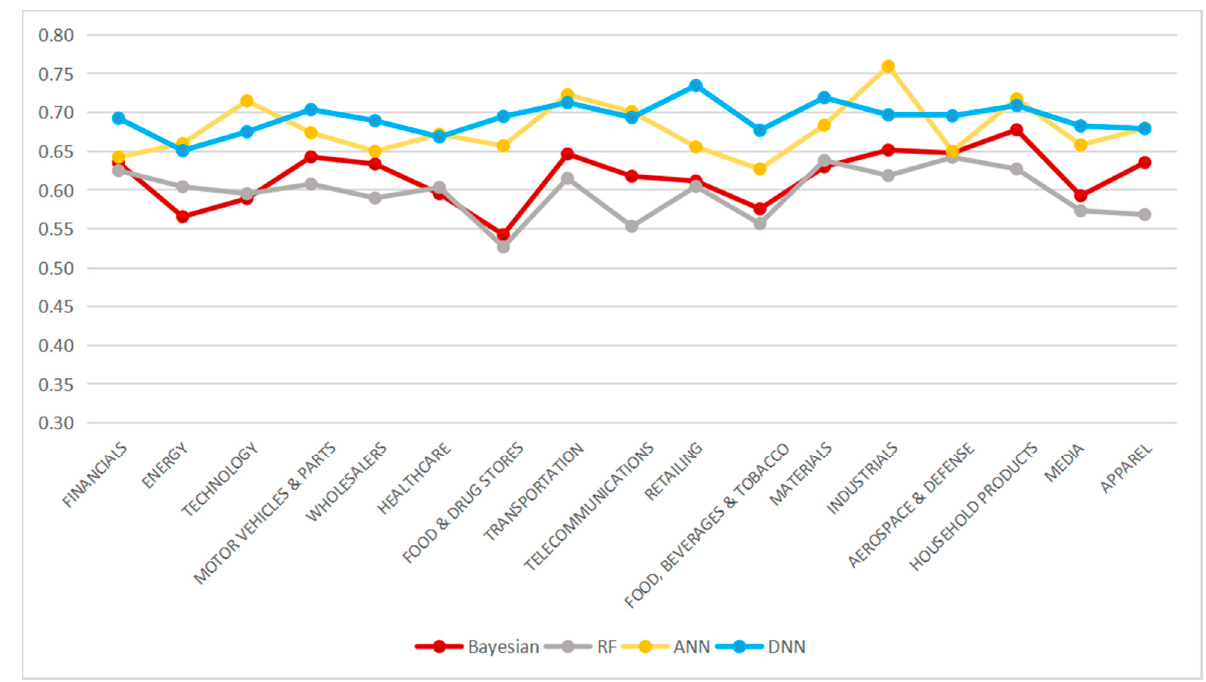
Figure 11. The evaluation of F1 score in industries.